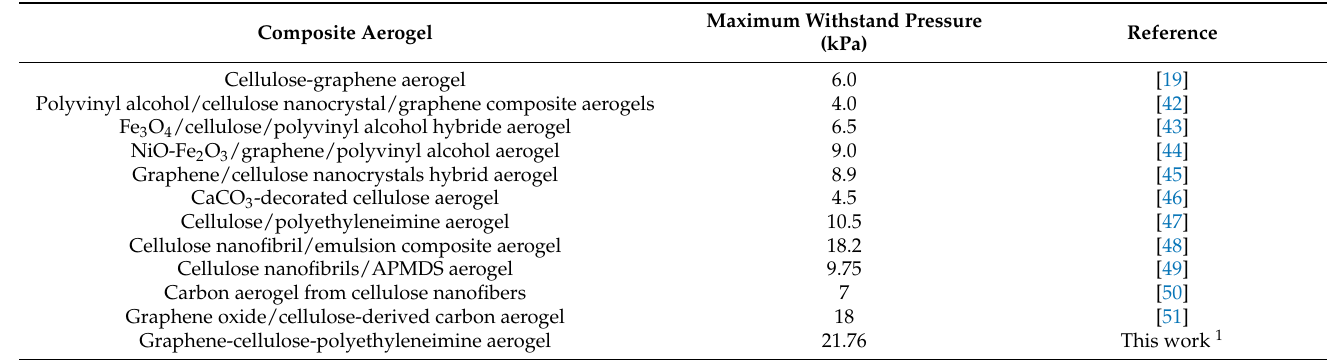
Table 4. Maximum allowable pressures of MCC composite aerogel, GA composite aerogel, and PEI composite